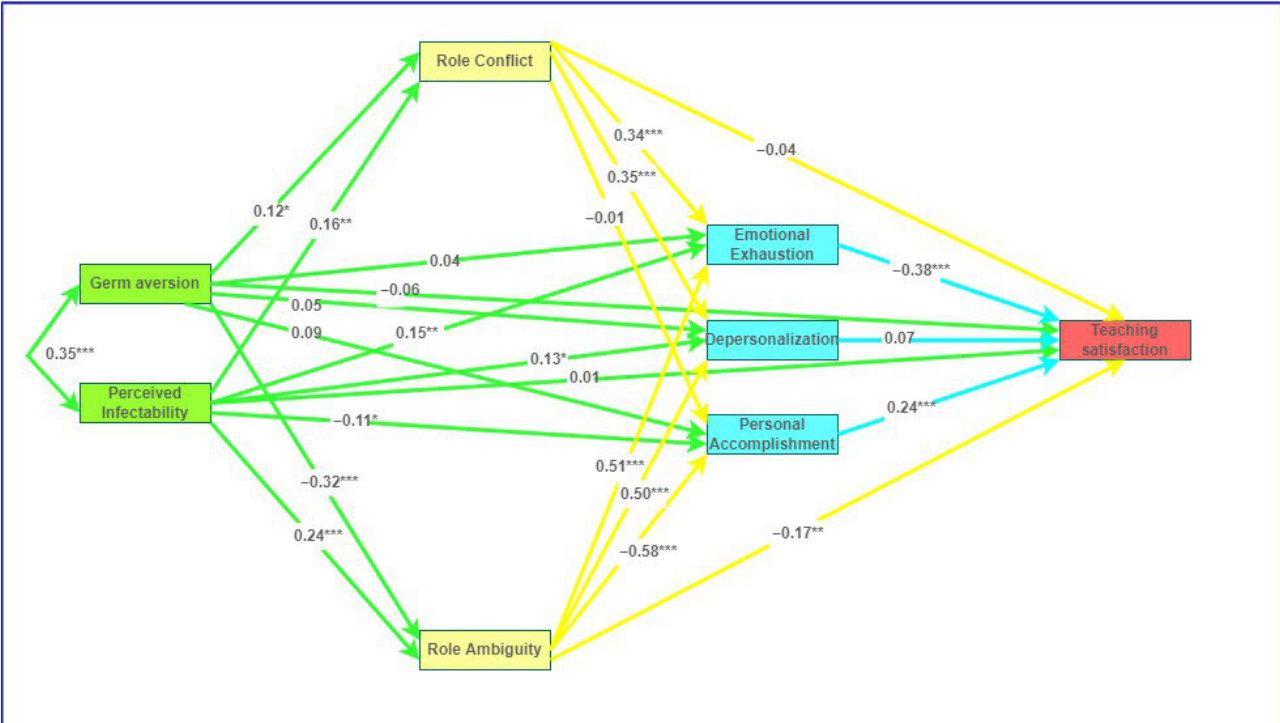
Figure 1. Structural equation model of the serial relationship between perceived vulnerability to disease and teacher satisfaction. Note: Regression weights are standardised. *** p < 0.001, ** p < 0.01, * p < 0.05.